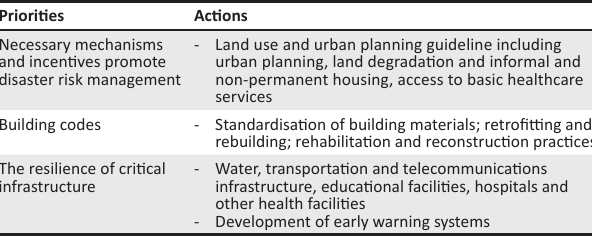
TABLE 1: Priorities for actions of the International Strategy for Disaster Reduction